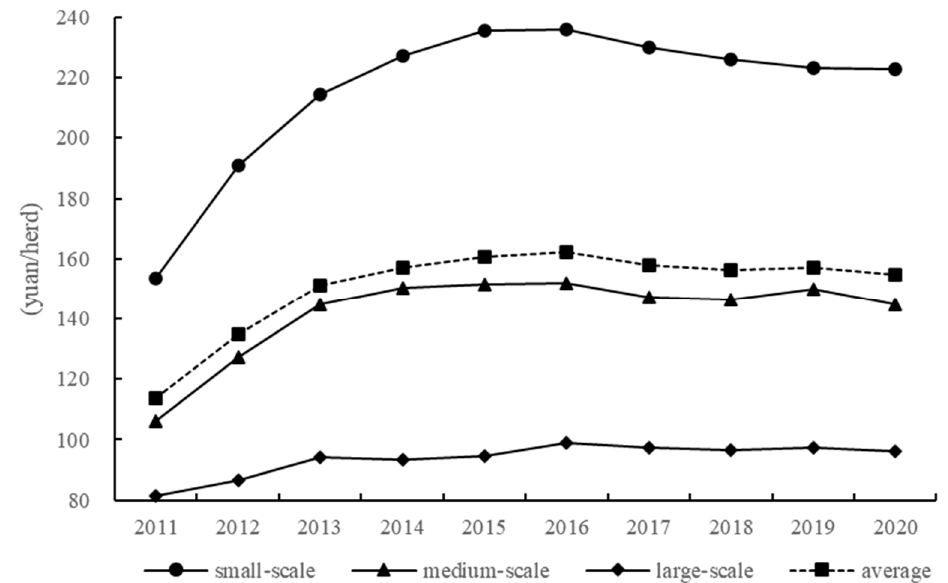
Figure 3. Annual labor costs of hog production of different scales in China from 2011 to 2020.